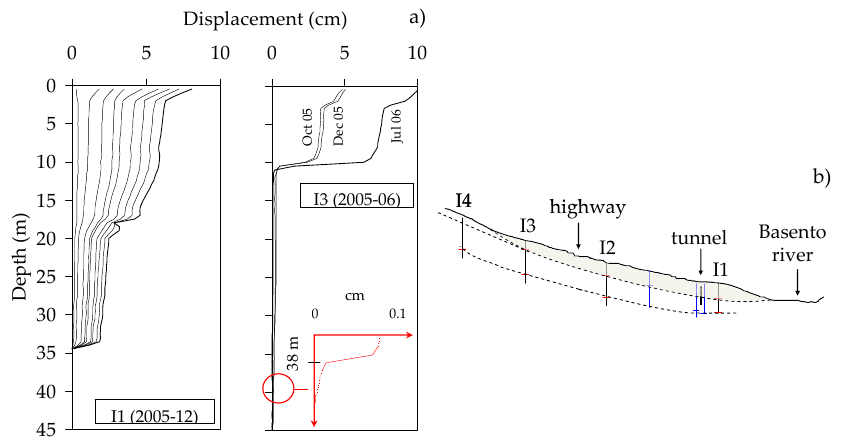
Figure 6. Inclinometer profiles I1 and I3 ( a ) and longitudinal section of the lower Varco d’Izzo earthflow ( b ). I3 went out of use in a year along the shallower slip surface, when the displacements on the deeper slip surface were small (as visible in the zoom relative to the profile of December 2005).